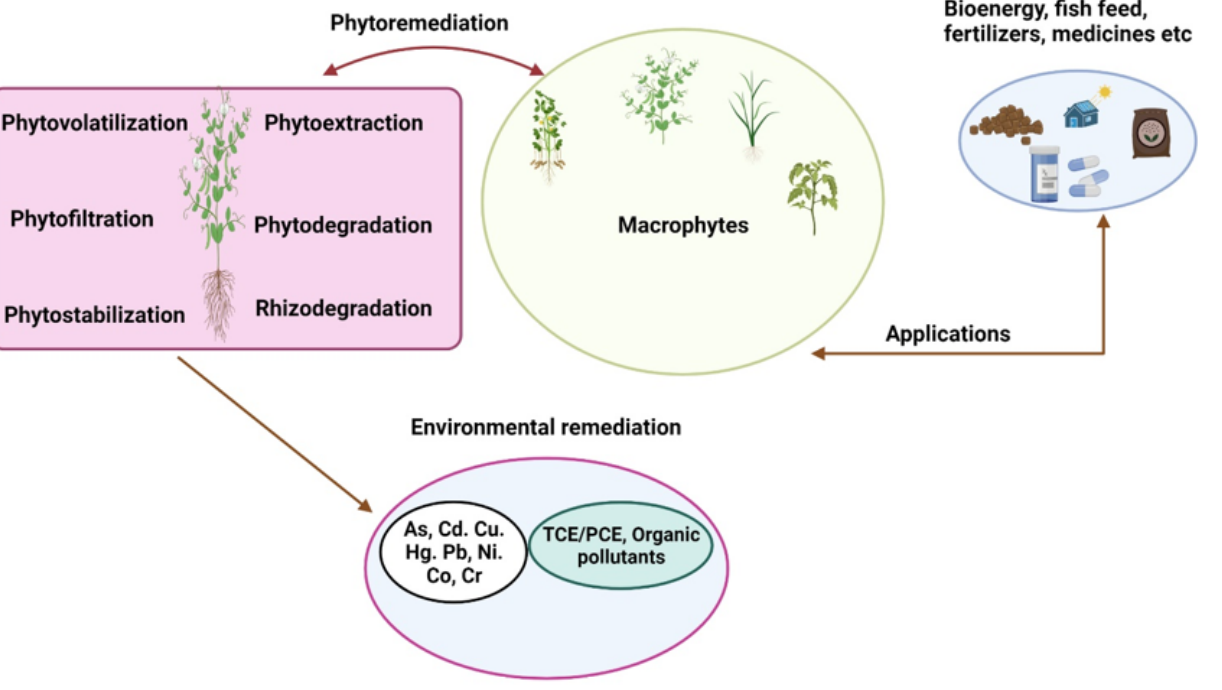
Figure 1. Perspectives of phytoremediation using macrophytes for the removal of heavy metals and other pollutants. Table 1. Application of hyperaccumulators for removal of heavy metals from contaminated soils by phytoremediation.